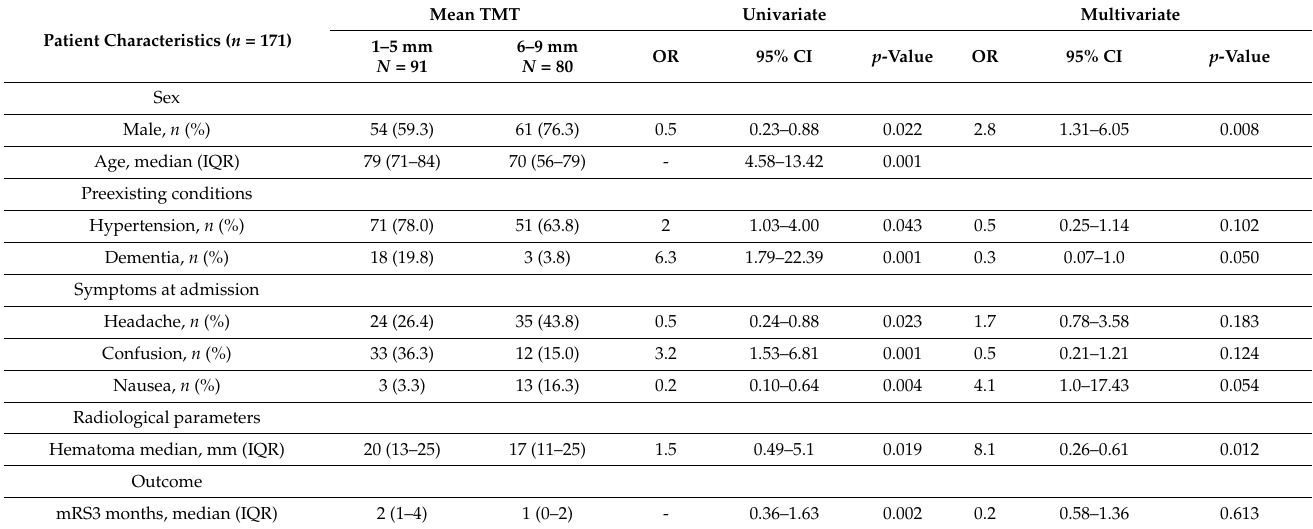
Table 3. Uni- and multivariate analysis of juxtaposed characteristics according to TMT volume in CSDH. Abbreviations: OR: odds ratio, IQR: interquartile range, GCS: Glasgow Coma Scale, CRP: C- reactive